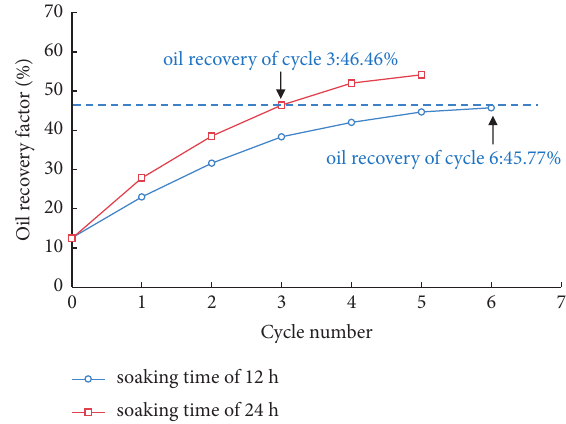
Figure 10: The difference between cumulative oil recovery factors of each huff-and-puff cycle with different soaking